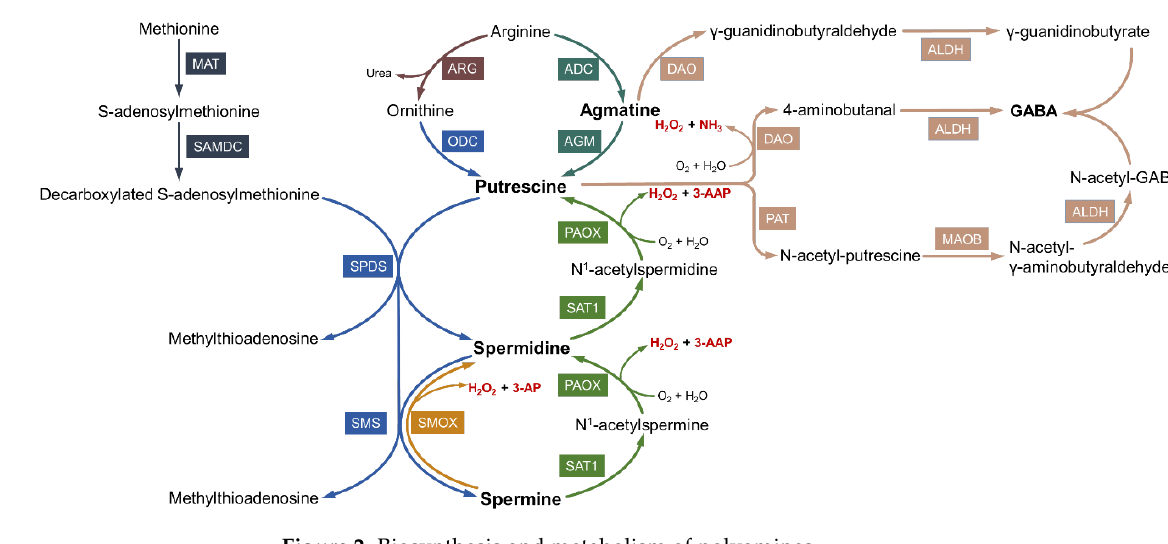
Figure 2. Biosynthesis and metabolism of polyamines.